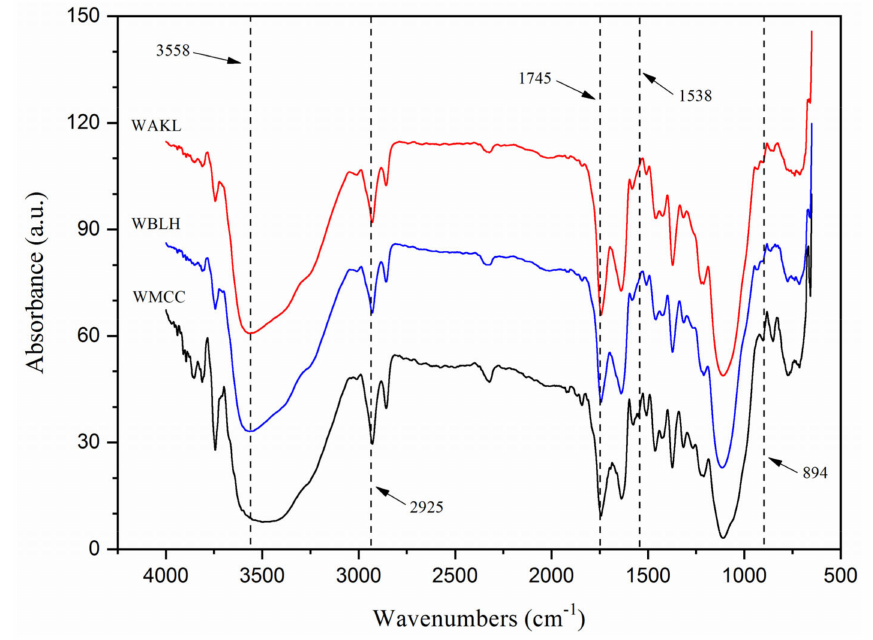
Figure 3. FTIR spectra of WAKL, WBLH and WMCC